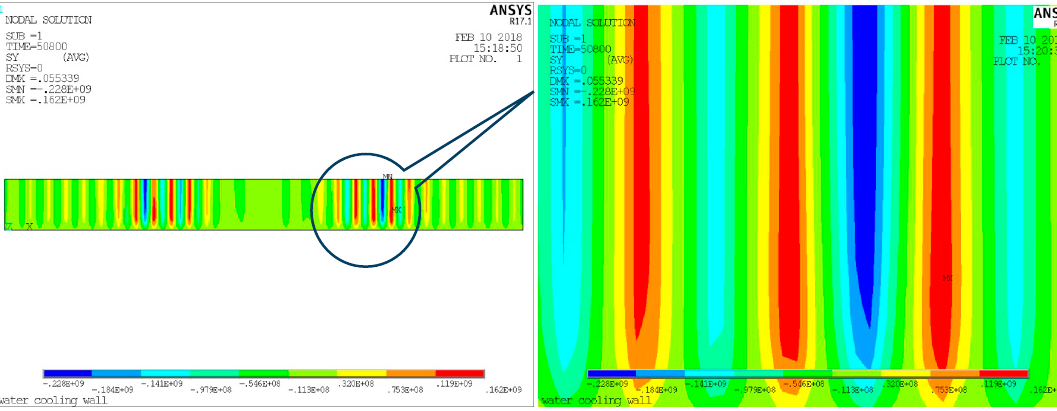
Figure 15. Thermal stress contour of the Y direction under the highest tube temperature difference.